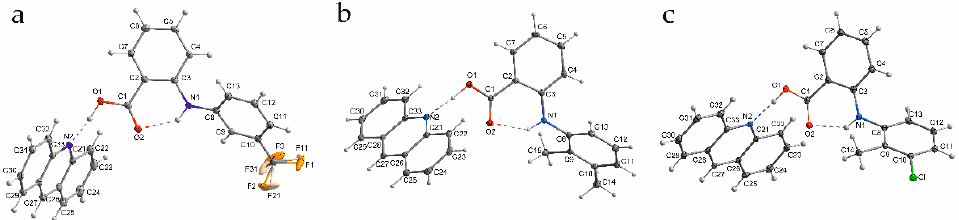
Figure 1. The investigated fenamic acid–acridine complexes: ( a ) flufenamic ( 1 ), ( b ) mefenamic ( 2 ) and ( c ) tolfenamic acid ( 3 ).